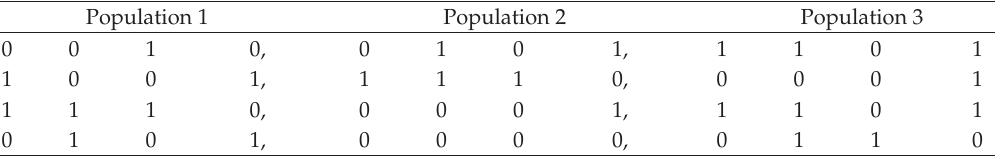
Table 2: Probability vectors and their corresponding